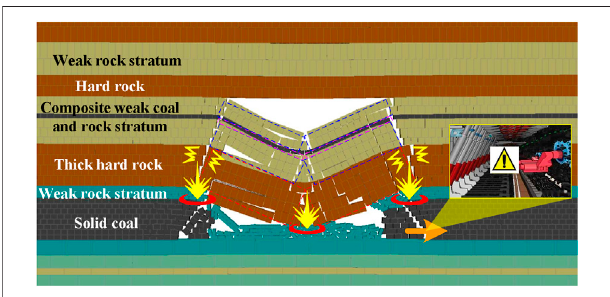
FIGURE 2 | Schematic diagram of mining dynamic pressure of the thick hard roof in the fully mechanized top-coal caving